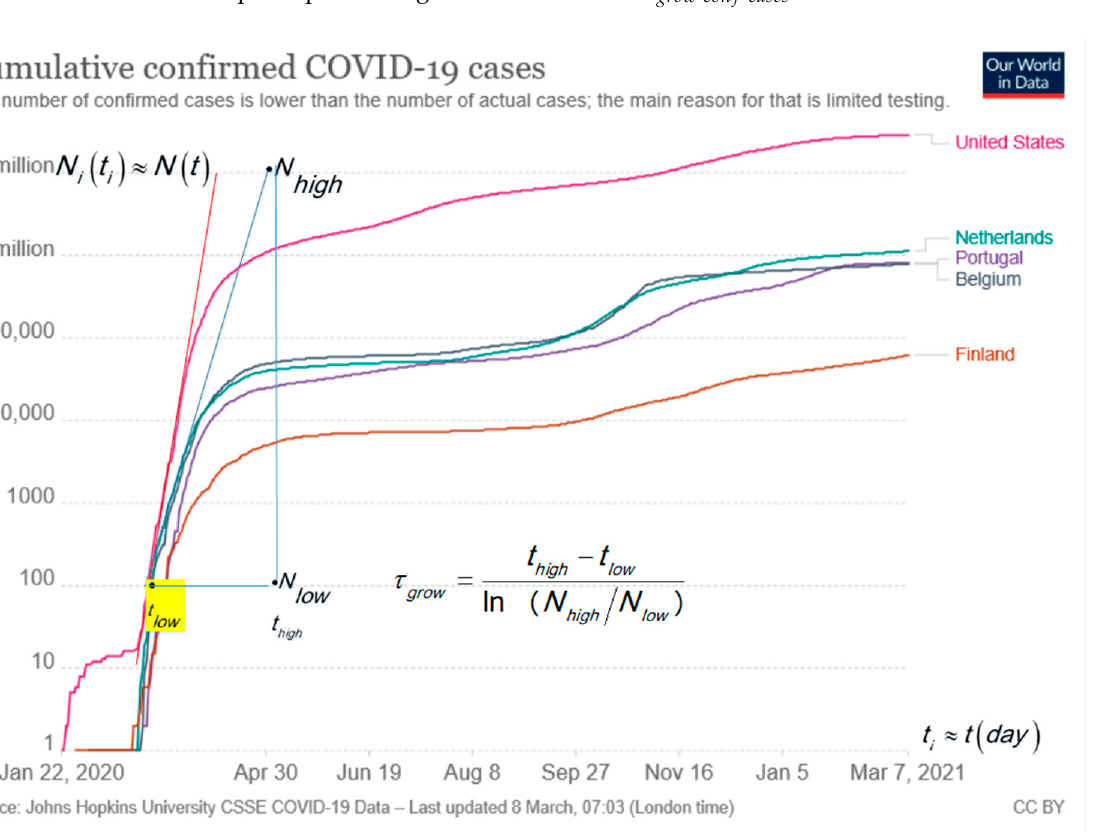
Figure 1. Cumulative number of confirmed COVID-19 cases in absolute numbers [1]. The advantage of a log–lin plot is that small and large numbers are visible. The typical S-shape of the curve in the lin–lin plot is lost in the log–lin presentation. The blue tangent line is for Portugal, Netherland and Belgium. The analysis gives [6]: τ grow ∼ = 5.3 d .